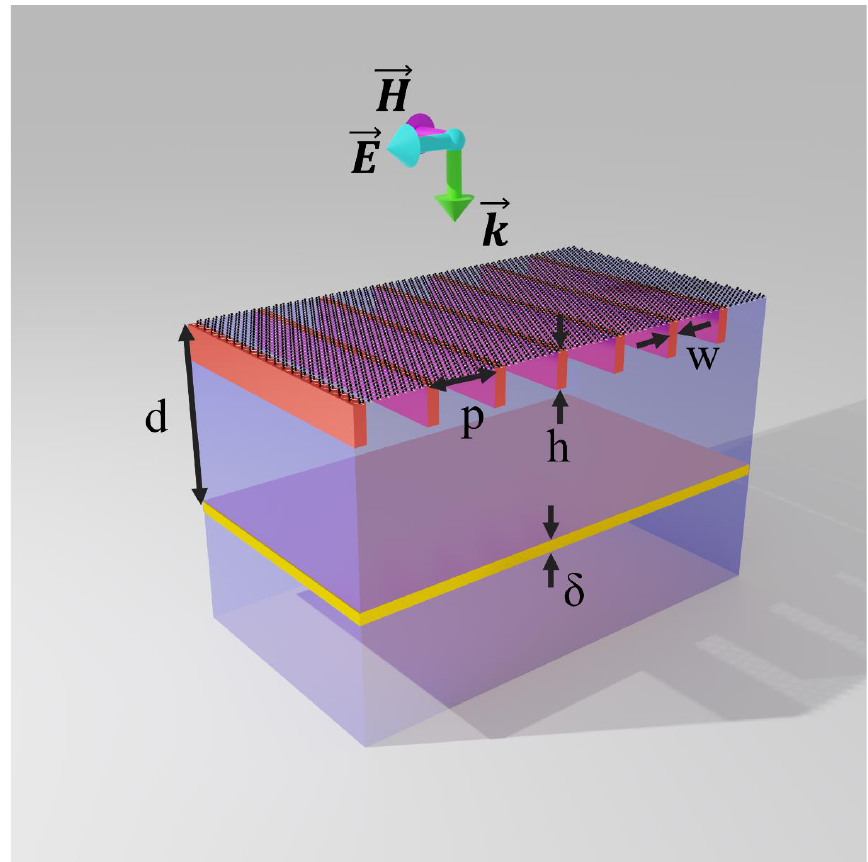
Figure 1. Cross-view of the proposed sensor structure, with its different geometrical parameters, and the normally incident plane wave excitation (polarization and wavevector.).